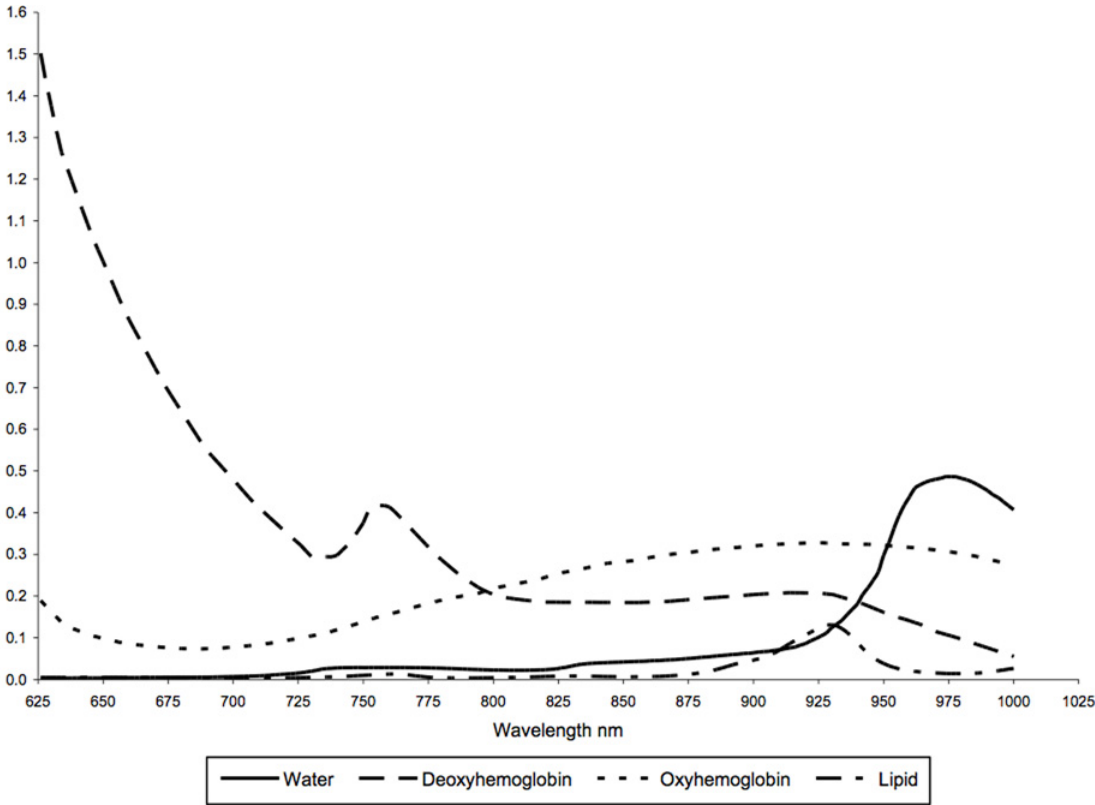
Figure 1. The attenuation spectra (optical density (OD) per cm over all wavelengths) of four main breast tissue components — water, lipid, oxyhemoglobin, and